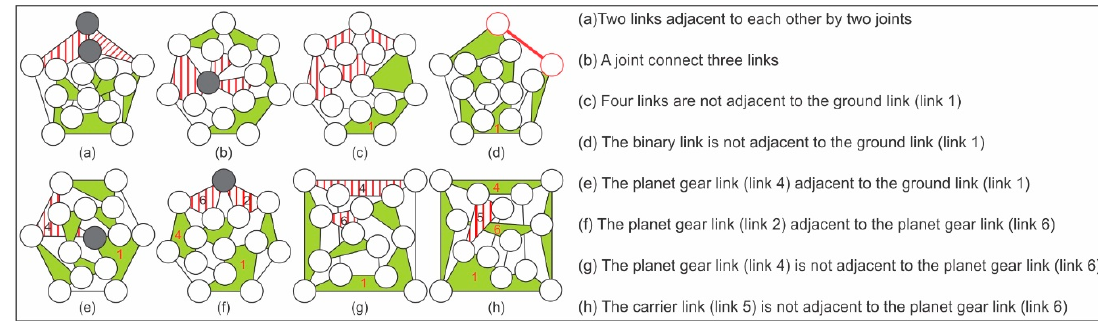
Figure 7. Infeasible generalized kinematic chains.